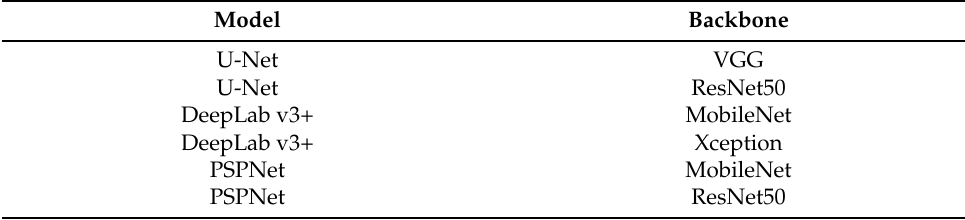
Table 3. The backbone network selection of the models.